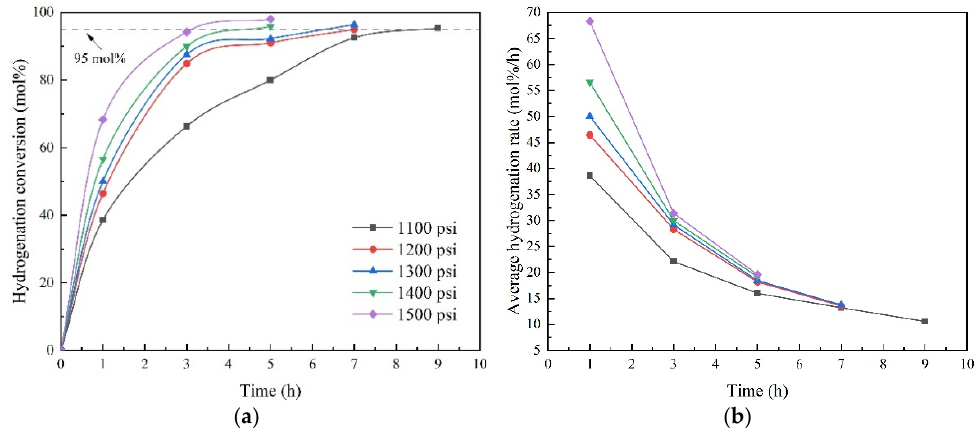
Figure 7. The XNBR conversion ( a ) and average hydrogenation ( b ) rates under a series of hydrogen pressure increases. Table 1. Vulcanization properties of the HXNBR compound.